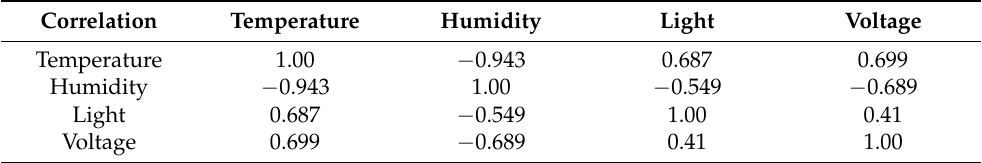
Table 5. Correlation of the signal-node.